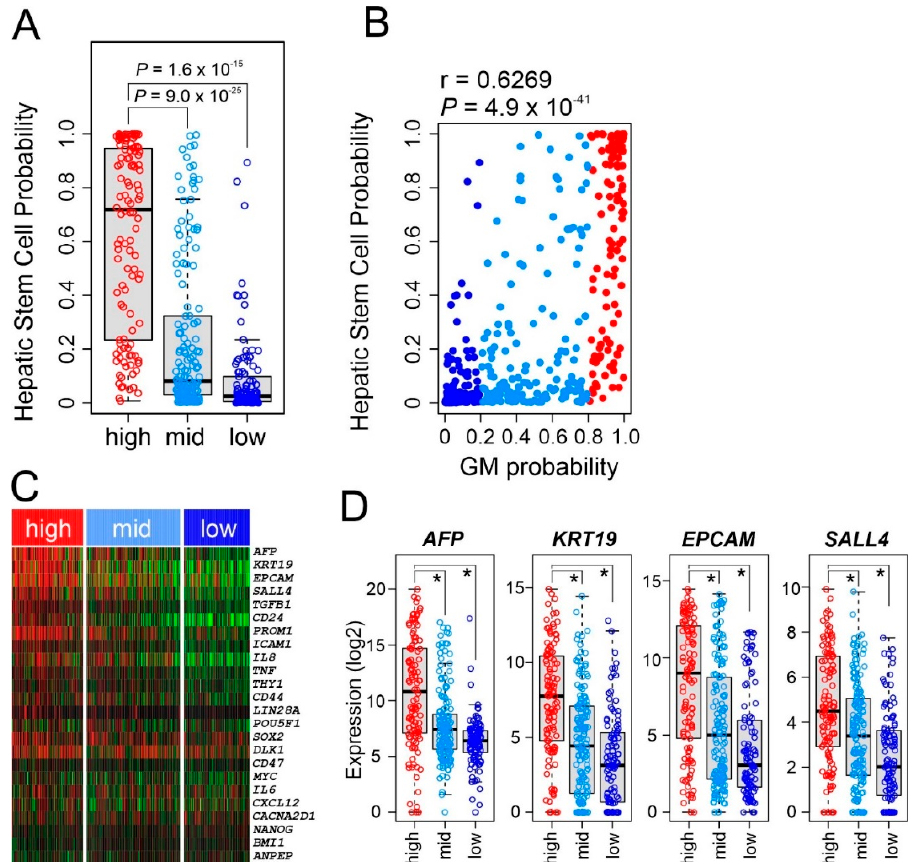
Figure 6. Stem cell characteristics of glycolysis metabolic (GM) subtypes. ( A ) Hepatic stem cell probability of hepatocellular carcinoma tumors in GM subtypes in The Cancer Genome Atlas (TCGA) cohort. In the box plots, the boundary of the box indicates the 25th to 75th percentile, and the black line within the box marks the mean. Whiskers above and below the box indicate the 10th and 90th percentiles. Each circle represents the fraction of the indicated immune cells in each tumor. Student t test. ( B ) Scatter plot for the correlation between hepatic stem cell probability and GM probability in the TCGA cohort ( n = 371). ( C ) Heatmap for expression of major stem-cell markers according GM subtype in the TCGA cohort. ( D ) Box plots of expression of stem cell markers according to GM subtype in the TCGA cohort. * p < 0.001 by Student t test.